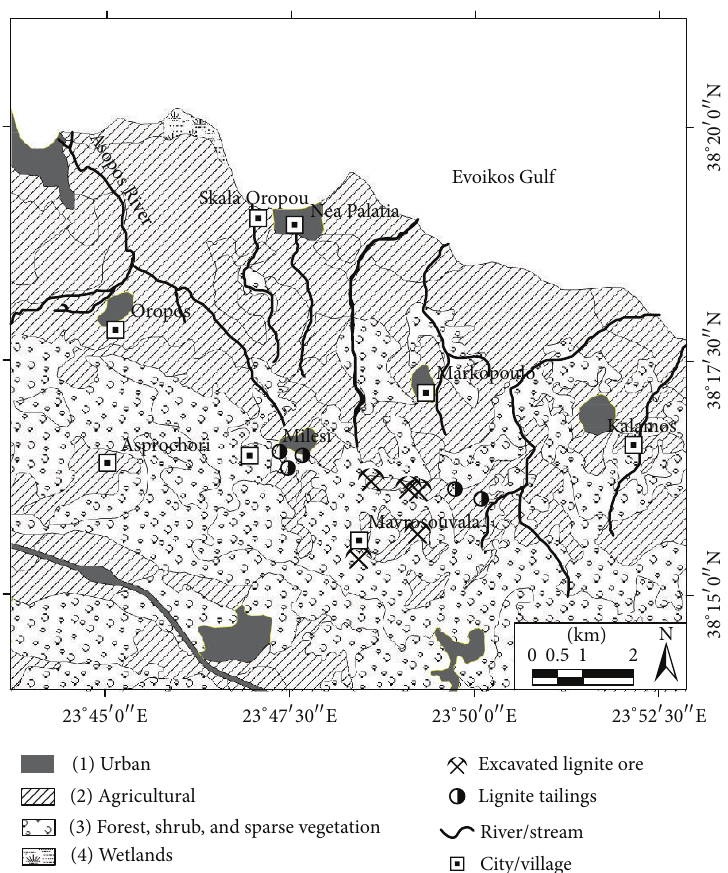
Figure 3: Map showing the land uses of the study area, rivers, streams, and names of the cities and villages.